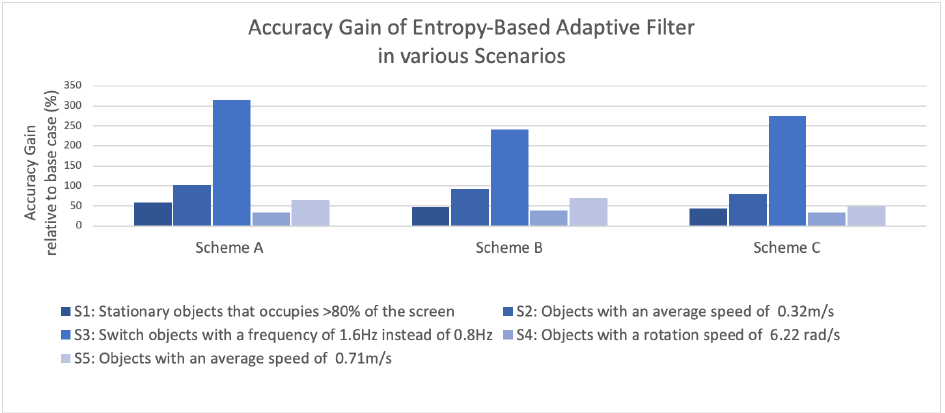
Figure 11. Accuracy gain provided by each schemes under diverse